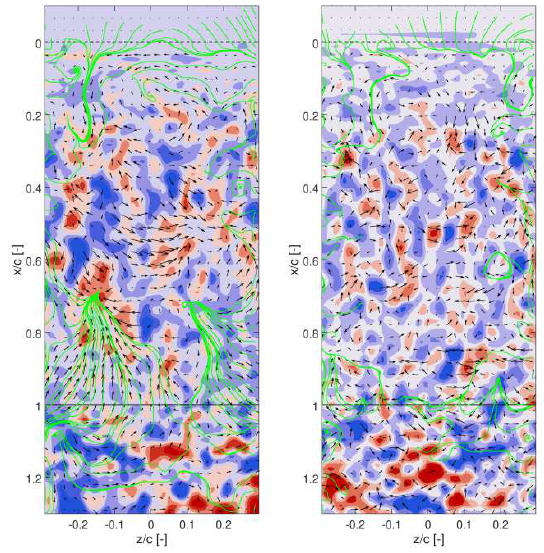
Fig. 9 . Spanwise slices of plane y w /c = 0.01 m . Velocity POD modes no. 6 (left) & 46 (right). Content 2.3% & 1.2% of TKE.